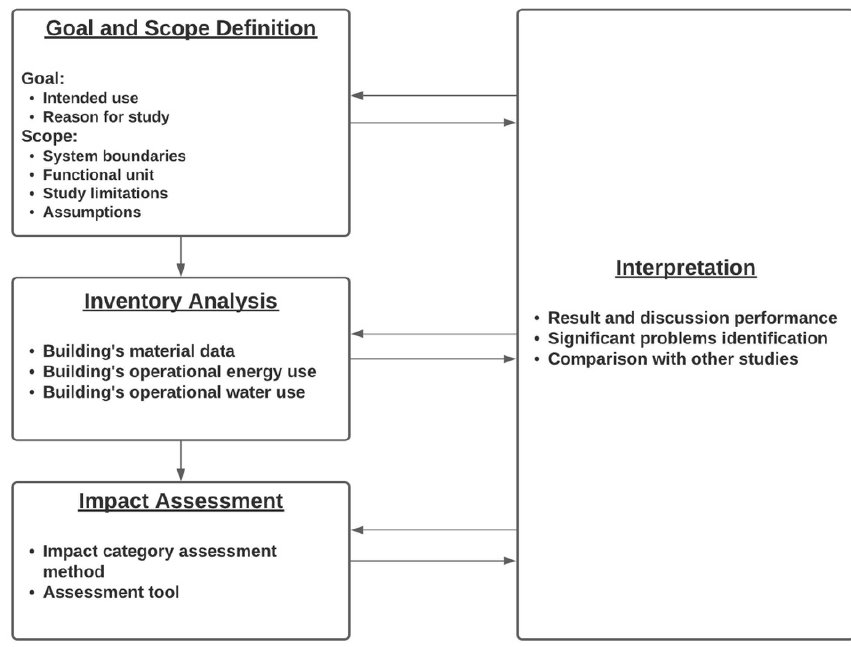
Figure 1. Life cycle analysis framework for the research.